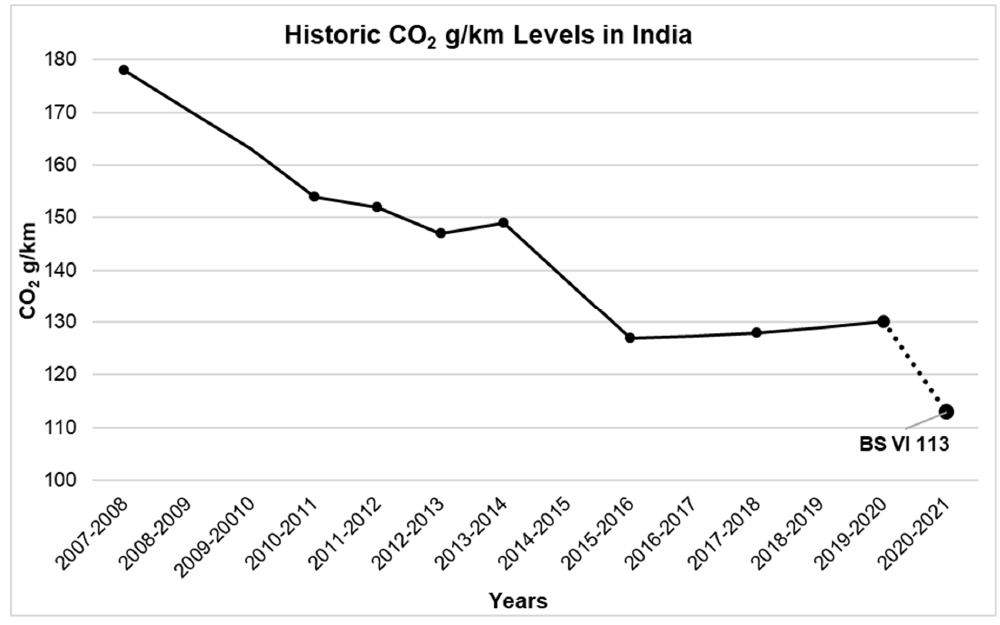
Figure 9. Historic CO 2 g/km emission levels in India.